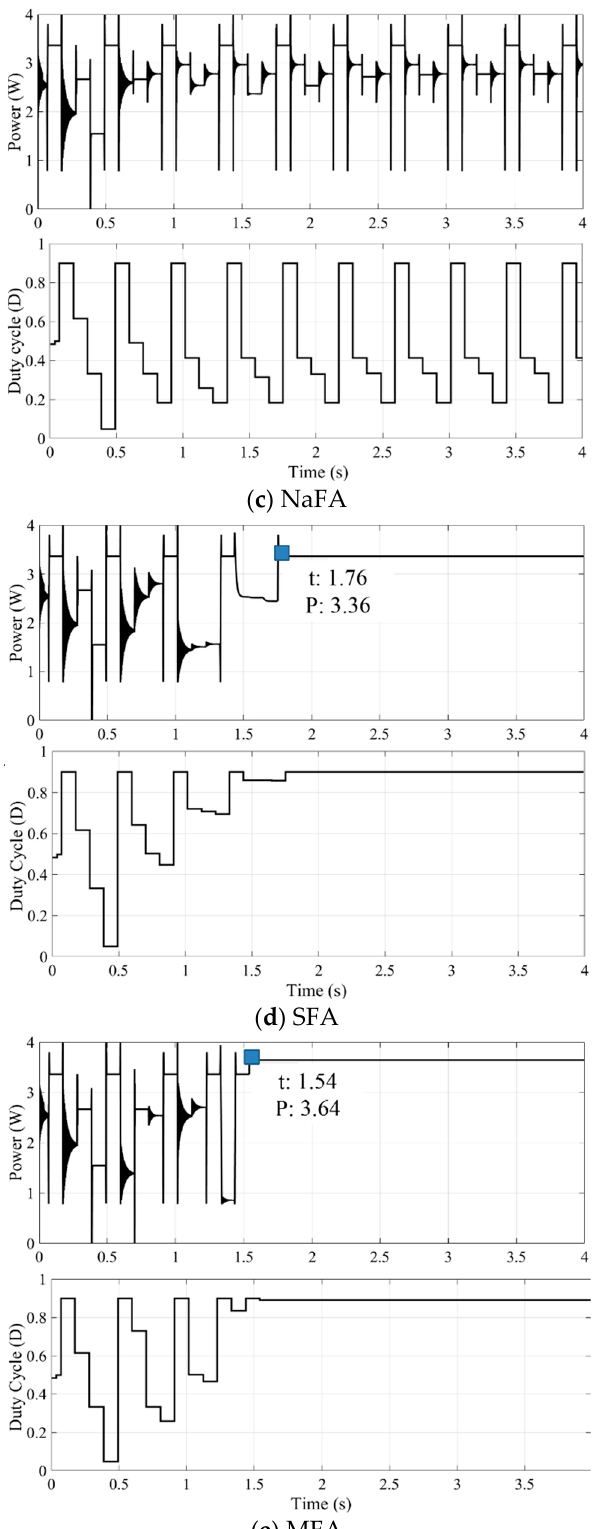
Figure 13. Power and duty cycle variations during one simulated tracking process for the five algorithms under PSC Pattern #4.